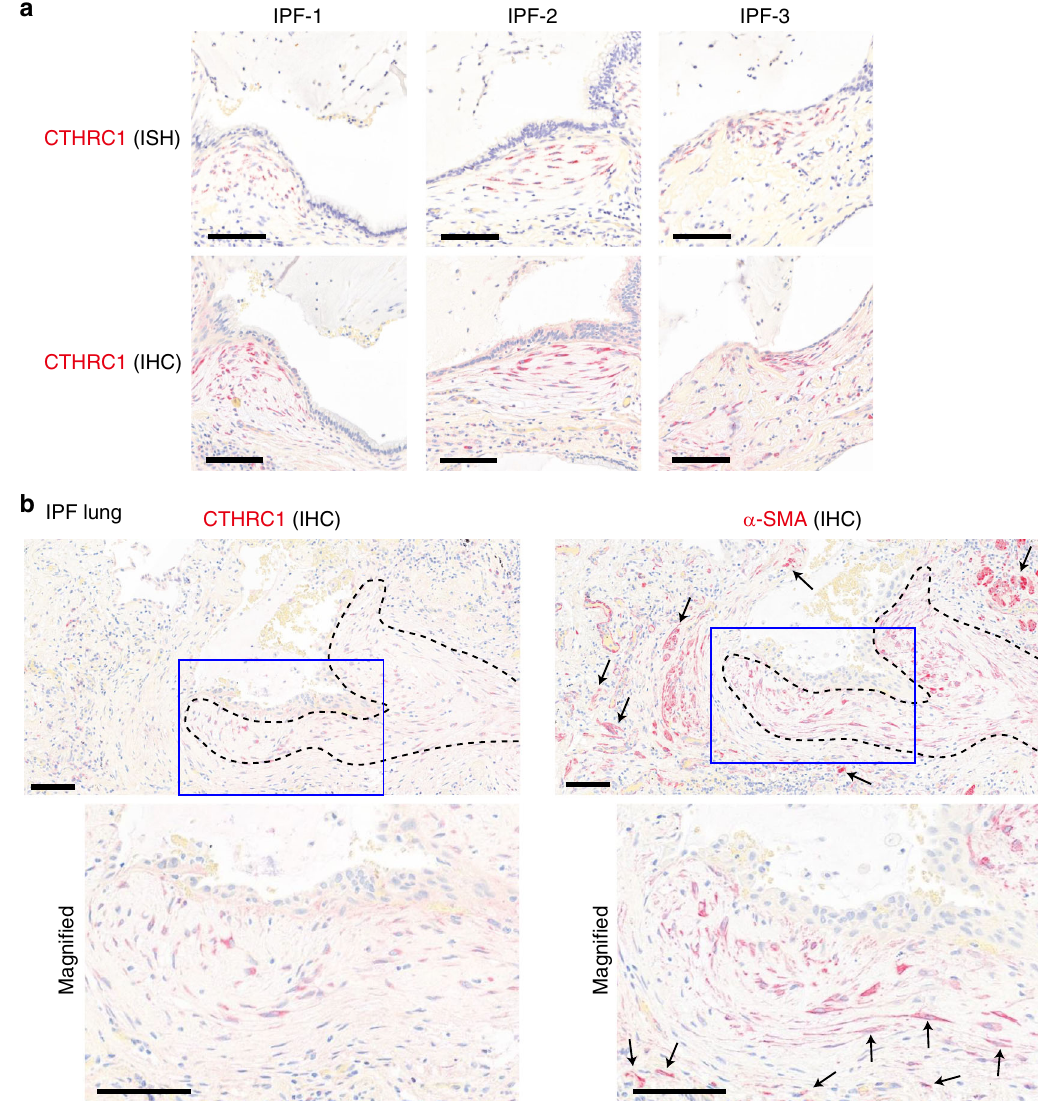
Fig. 6 CTHRC1 + pathologic fi broblasts are localized within fi broblastic foci in IPF. a Representative images of in situ hybridization (ISH) and immunohistochemistry (IHC) for CTHRC1 in the sections from three IPF patients. Scale bars, 100 μ m. b CTHRC1 and α -SMA antibody staining in sequential sections of IPF lungs. Fibroblastic foci are outlined by dotted lines. Areas inside blue squares are magni fi ed in lower panels. Arrows indicate α -SMA + cells outside CTHRC1 + areas. Images are representative from four IPF patients. Scale bars, 100 μ